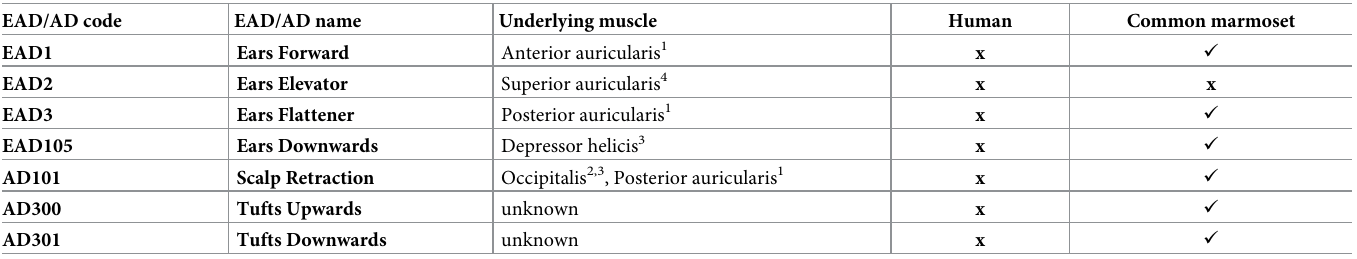
Table 2. Comparison between FACS movements for ears and related movements of the tufts and scalp for humans [3] and common marmosets [51, 52, 57], accord- ing to underlying musculature, including Ear Action Descriptors (EAD) and Action Descriptors (AD). ✓ - present, x—absent. EAD/AD